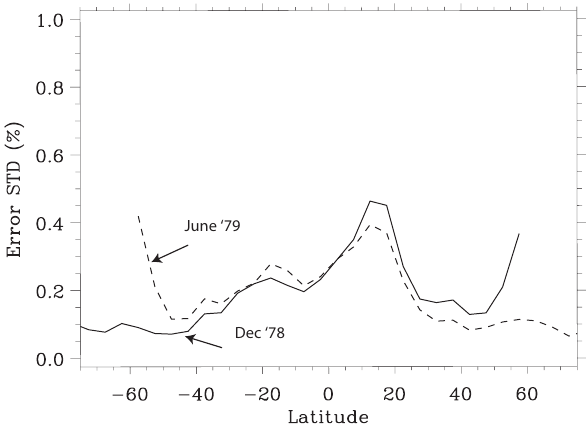
Fig. 12. Typical latitude dependence of smoothing error (1 σ) in es- Figure 12. Typical latitude dependence of smoothing error (1 σ ) in estimating MZM of timating MZM of total column O 3 from SBUV. These errors are total column O 3 from SBUV. These errors are caused by reduced sensitivity of the algorithm to tropospheric ozone variations seen in Fig. 6, which gets worse at larger caused by reduced sensitivity of the algorithm to tropospheric ozone SZAs. Larger errors in northern tropics are caused by larger inter-annual variability of variations seen in Fig. 6, which gets worse at larger SZAs. Larger tropospheric ozone. Since they are based on very limited number of ozonesonde stations, they may not be reliable. errors in northern tropics are caused by larger interannual variabil- ity of tropospheric ozone. Since they are based on a very limited number of ozonesonde stations, they may not be